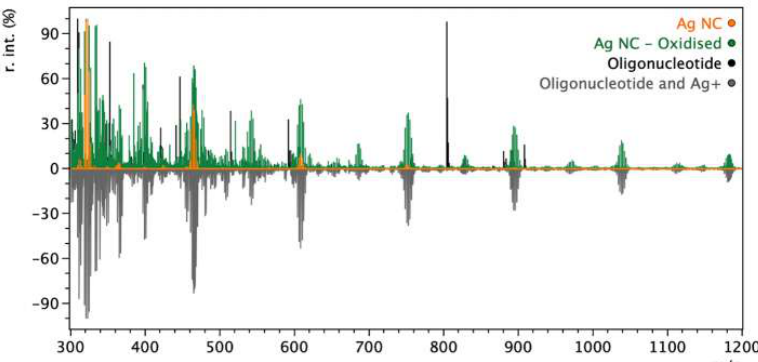
Figure2. MALDI-MSoftheoligonucleotide(black),oligonucleotidewithAgNO 3 (grey,“Oligonucleotideand Figure 2. MALDI-MS of the oligonucleotide (black), oligonucleotide with AgNO 3 (grey, “Oligonucleotide and Ag + ”), Ag NC after reduction (orange) and the oxidized Ag NC (green, “Ag Ag + ”), Ag NC after reduction (orange) and the oxidized Ag NC (green, “Ag NC—Oxidised). The spectrum NC—Oxidised). The spectrum of oligonucleotide and is shown inverted for easier comparison with of oligonucleotide and is shown inverted for easier comparison with the other data. Individual spectra and the other data. Individual spectra and peaks are shown in Figures S4–S7, and Table S1. peaks are shown in Figures S4–S7, and Table Ag NCs contained 3–8 atoms, shown by MALDI-MS and determined by comparing peaks to Ag isotope distributions [38]. At 465 and 894 m/z (Figure 3a,d), there were distributions of six peaks (with two centre peaks), indicating Ag 5 NCs. Seven peak distributions (with one centre peak) at 752 and 608 m/z (Figure 3b,c) indicated Ag 6 NCs. These Ag NC peaks were distinct from the oligonucleotide peaks present in the spectra of the oligonucleotide on its own, which begin with a tall peak followed by at least two peaks descending in height (Figure 4e). The MALDI spectrum for the Ag NC shows a distant change compared to the oligonucleotide on its own. When oxidized, the spectrum changes to show peaks present in both the oligonucleotide and the Ag NC, indicating a change in cluster structure. Transition electron microscopy (TEM) images were not acquired because at the size of these Ag NCs. Typical TEM images do not show the true size of the Ag NCs, rather showing aggregates that are formed during measurement [39–41]. Figure 3. Corresponding MALDI-MS spectra for oligonucleotide on its own and Ag NCs showing 3– 8 Ag atom Ag NCs ( e ) and zoomed regions of peaks of interest ( a – d ). The oligonucleotide on its own